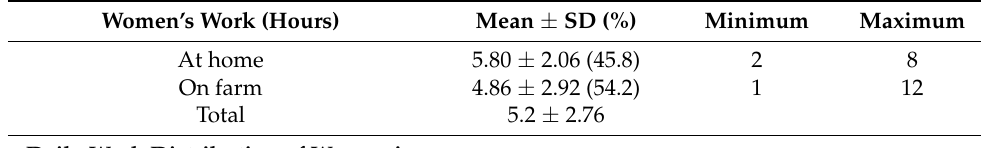
Table 4. Daily work distribution of women dairy goat farmers